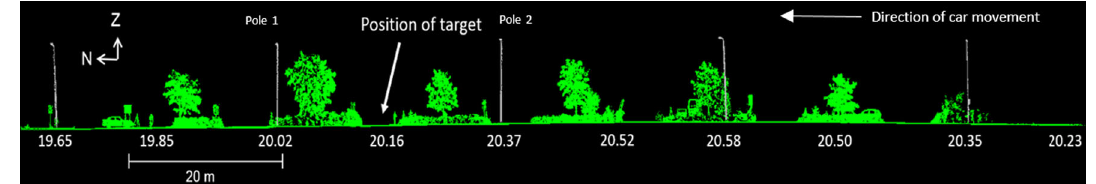
Fig. 2 Profile view of the TLS measurement on the Otaranta Street, the numbers are road heights